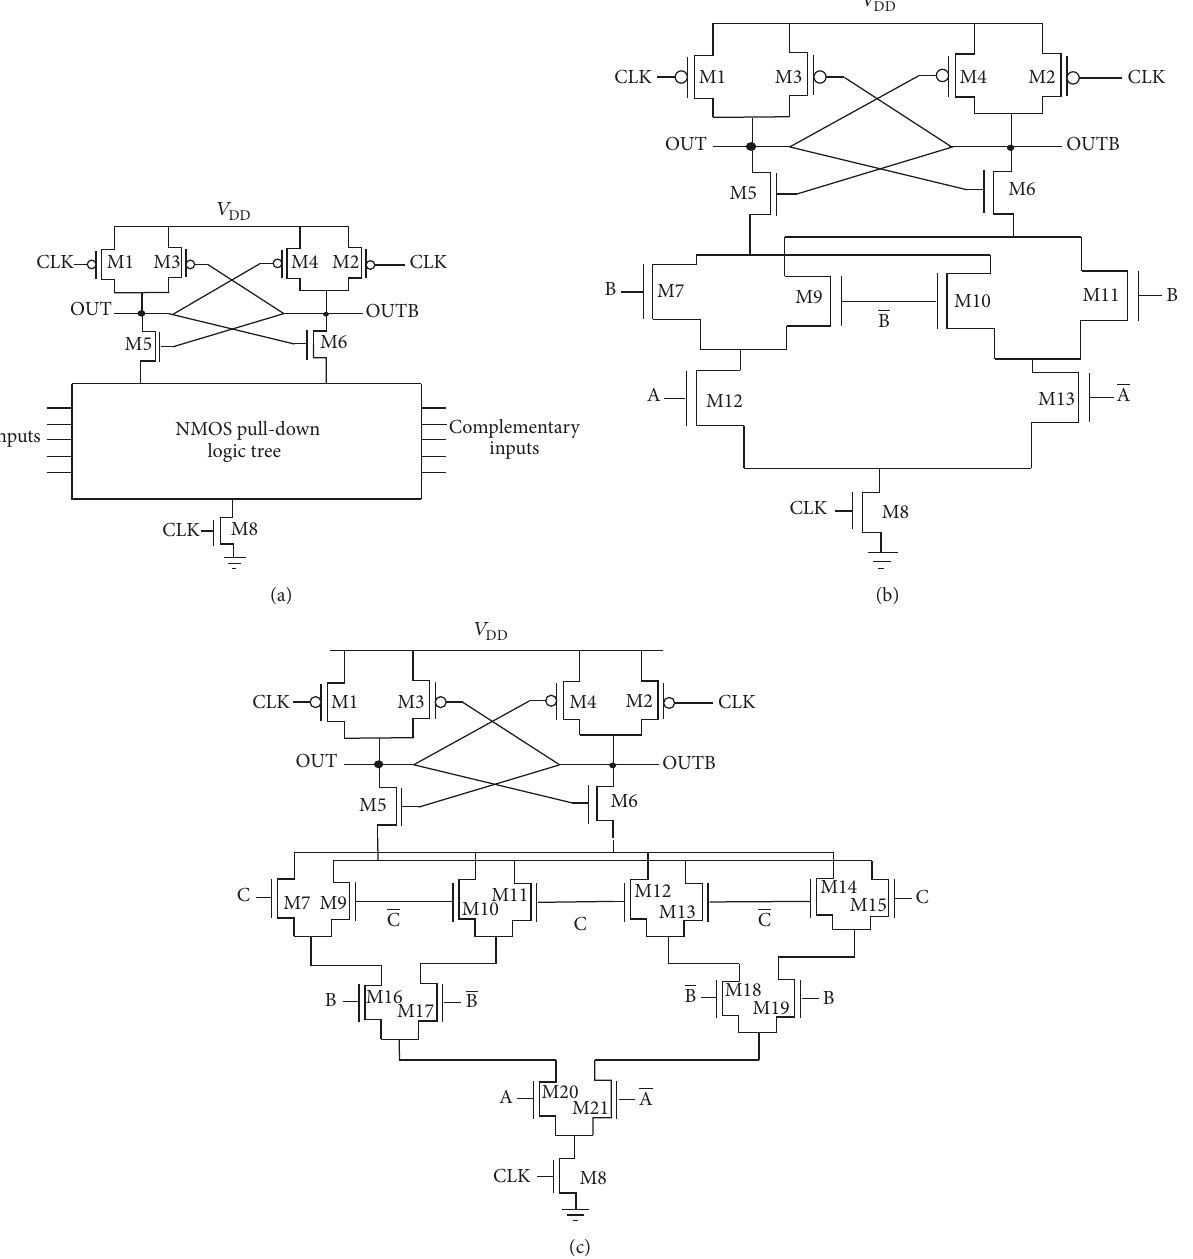
Figure 1: (a) Generic architecture of Dy-DCVSL circuit: (b) two- and (c) three-input Dy-DCVSL XOR-XNOR gate.